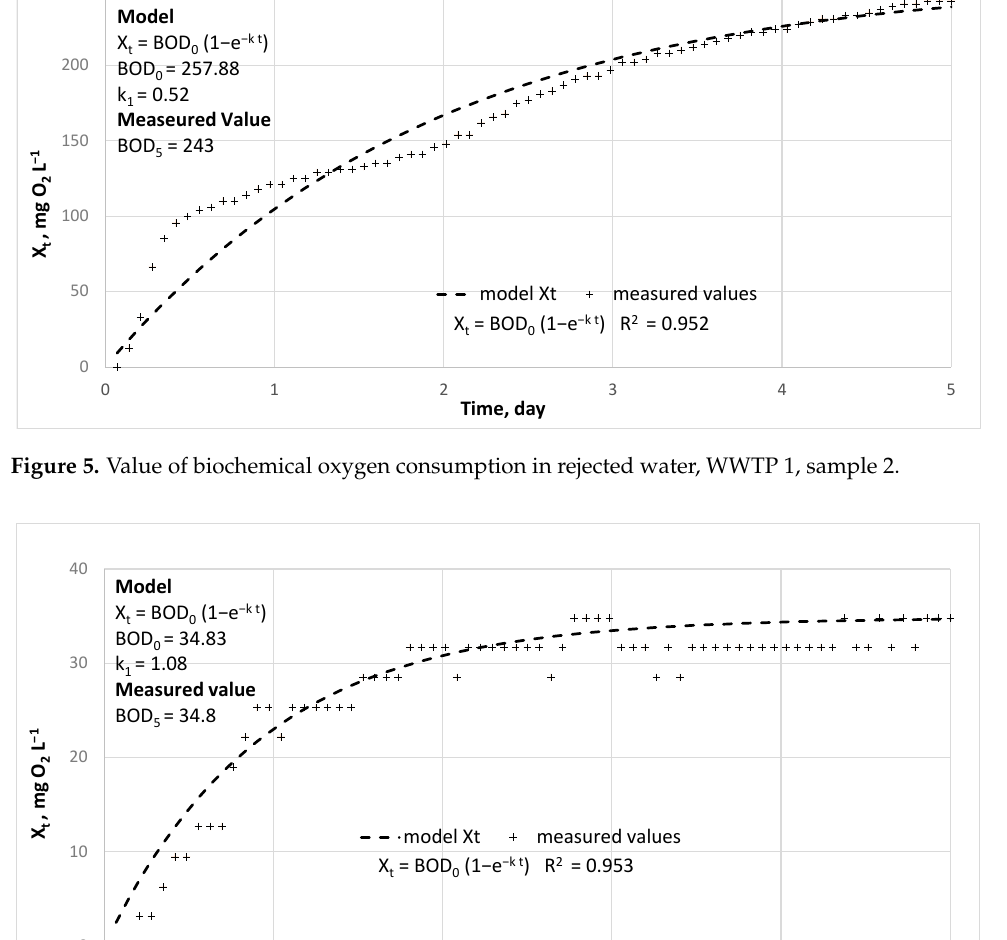
Figure 8. Value of biochemical oxygen consumption in rejected water, WWTP 3, sample 1.